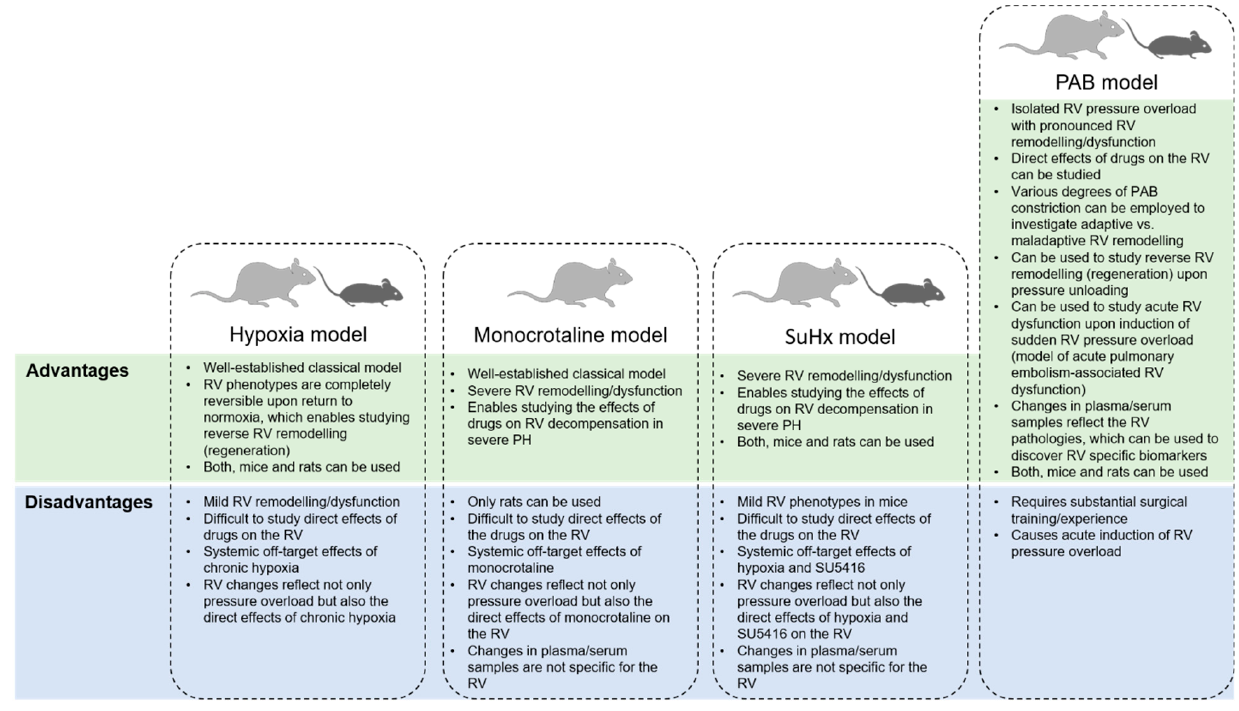
Figure 1. Advantages and disadvantages of pulmonary artery banding (PAB) model of right ventricular (RV) failure.